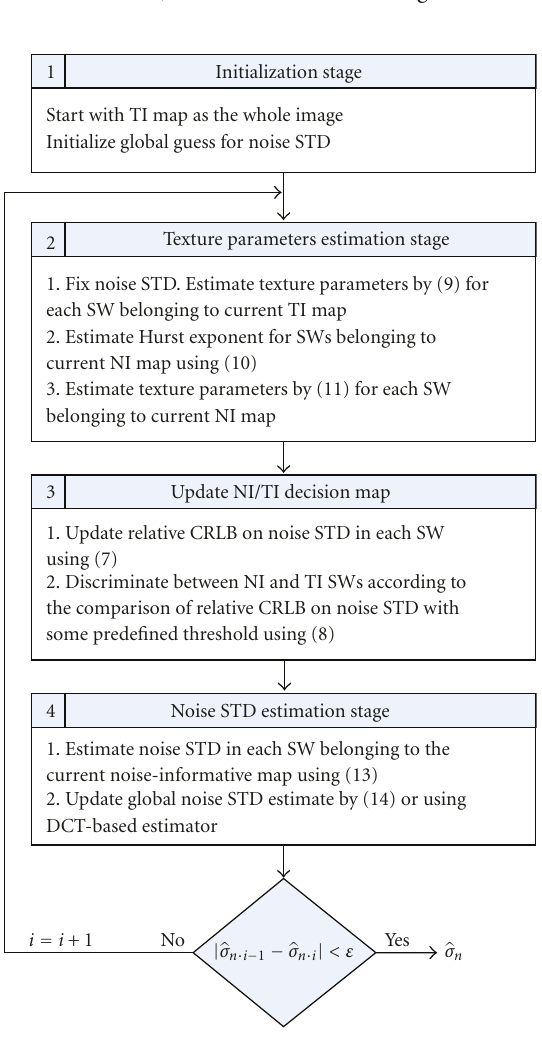
Figure 3: Generalized scheme of the proposed iterative noise STD estimation